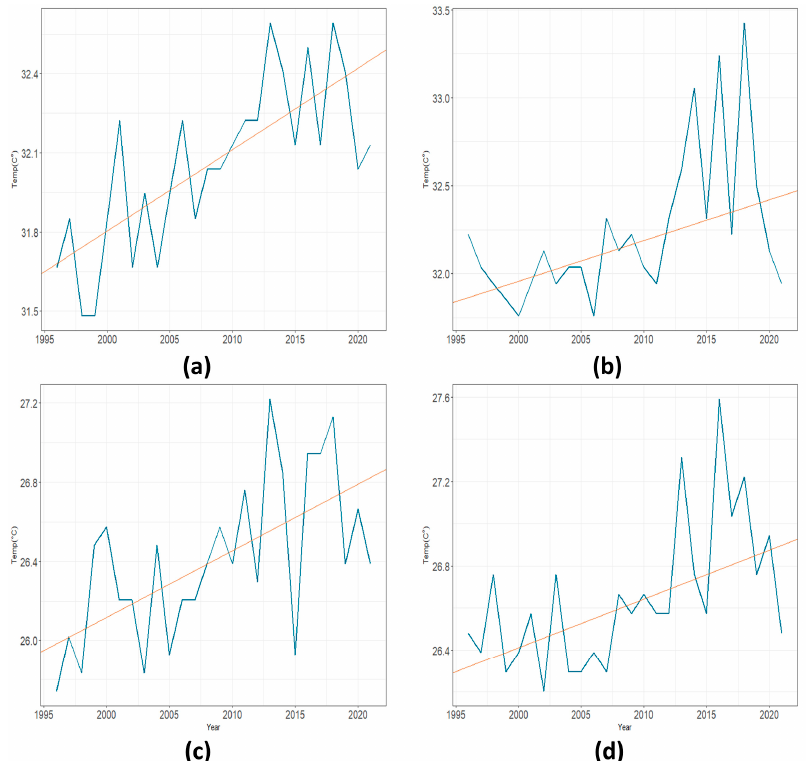
Figure 4. Trends in two-seasonal maximum of Tmax (TXx) and Tmin (TNx) over 1996–2021 at GIAP. ( a ) dry-season of TXx, ( b ) wet-season of TXx, ( c ) dry-season of TNx, and ( d ) wet-season of TNx. Red lines are Theil–Sen regression lines.